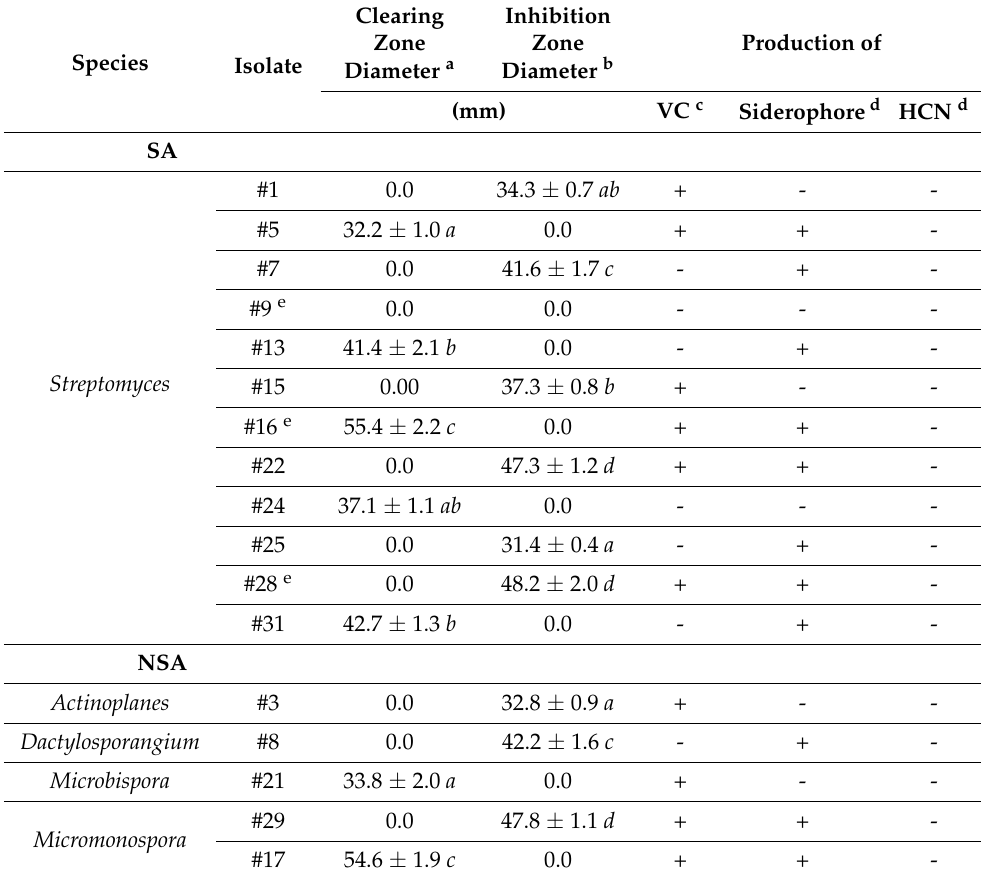
Table 1. Antagonism against Fusarium solani by endophytic actinobacterial isolates obtained from within date palm root